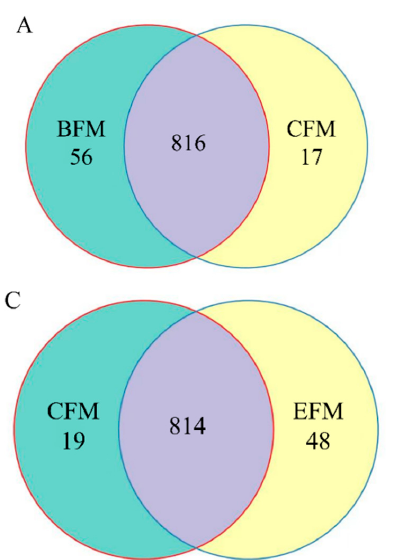
Figure 6. Venn diagram based on OTU feature. ( A ) OTUs Venn diagram of fecal microbiota between BFM and CFM groups; ( B ) BFM and EFM groups; ( C ) CFM and EFM groups. BFM: fecal microbiota before the experiment; CFM: fecal microbiota in the counterpart group after the experiment; EFM: fecal microbiota in the experimental group after the experiment.